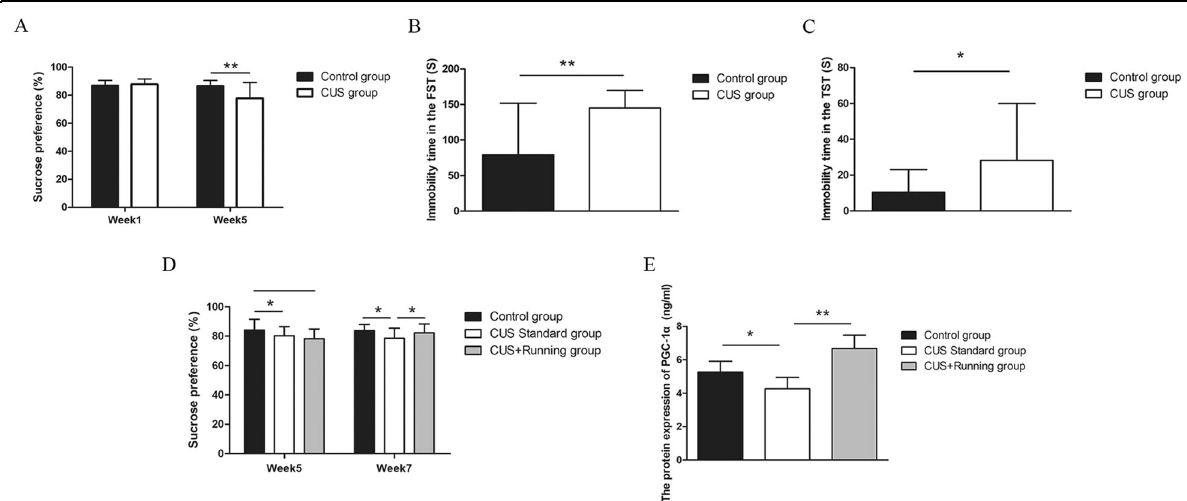
Fig. 1 The effects of running exercise on the depressive-like behaviors and protein expression of PGC-1 α in the hippocampus of mice in different groups. A – C The sucrose preference changes, immobility time in the FST and TST (mean ± SD) of mice in the control group ( n = 18) and the CUS group ( n = 42) for the fi rst fi ve weeks. * indicates p < 0.05, and ** indicates p < 0.001. D The sucrose preference changes (mean ± SD) of mice among the control group ( n = 18), the CUS Standard group ( n = 20), and the CUS + Running group ( n = 22) for the last two weeks. * indicates p < 0.05. E The protein expression of PGC-1 α in the hippocampus of the mice in the control group ( n = 5), the CUS Standard group ( n = 5) and the